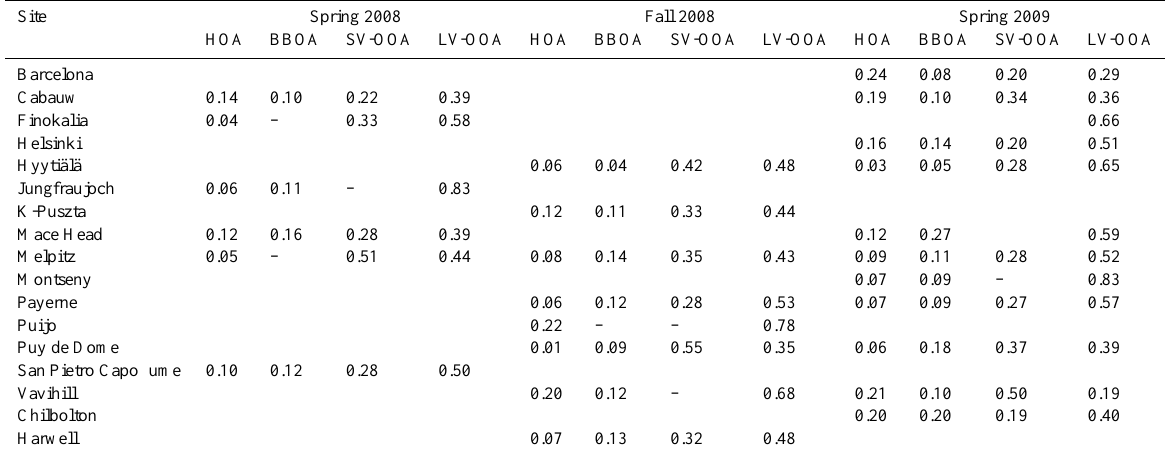
Table 2. Relative contributions of the identified organic components to the total OA. Note that only main organic sources in common for most of the sites are reported (HOA, BBOA, SV-OOA and LV-OOA). Site